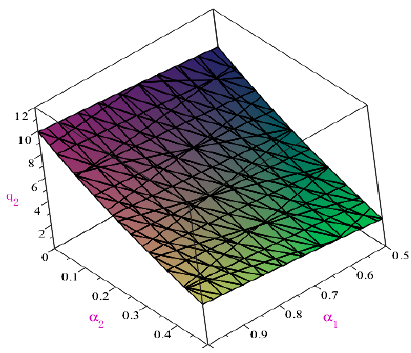
q with α 1 and α 2 ( Figure 6. Changes of q ∗ 2 with α 1 and α 2 (0.5 < α 1 ≤ 1, α 2 ≤ 0.5). 2